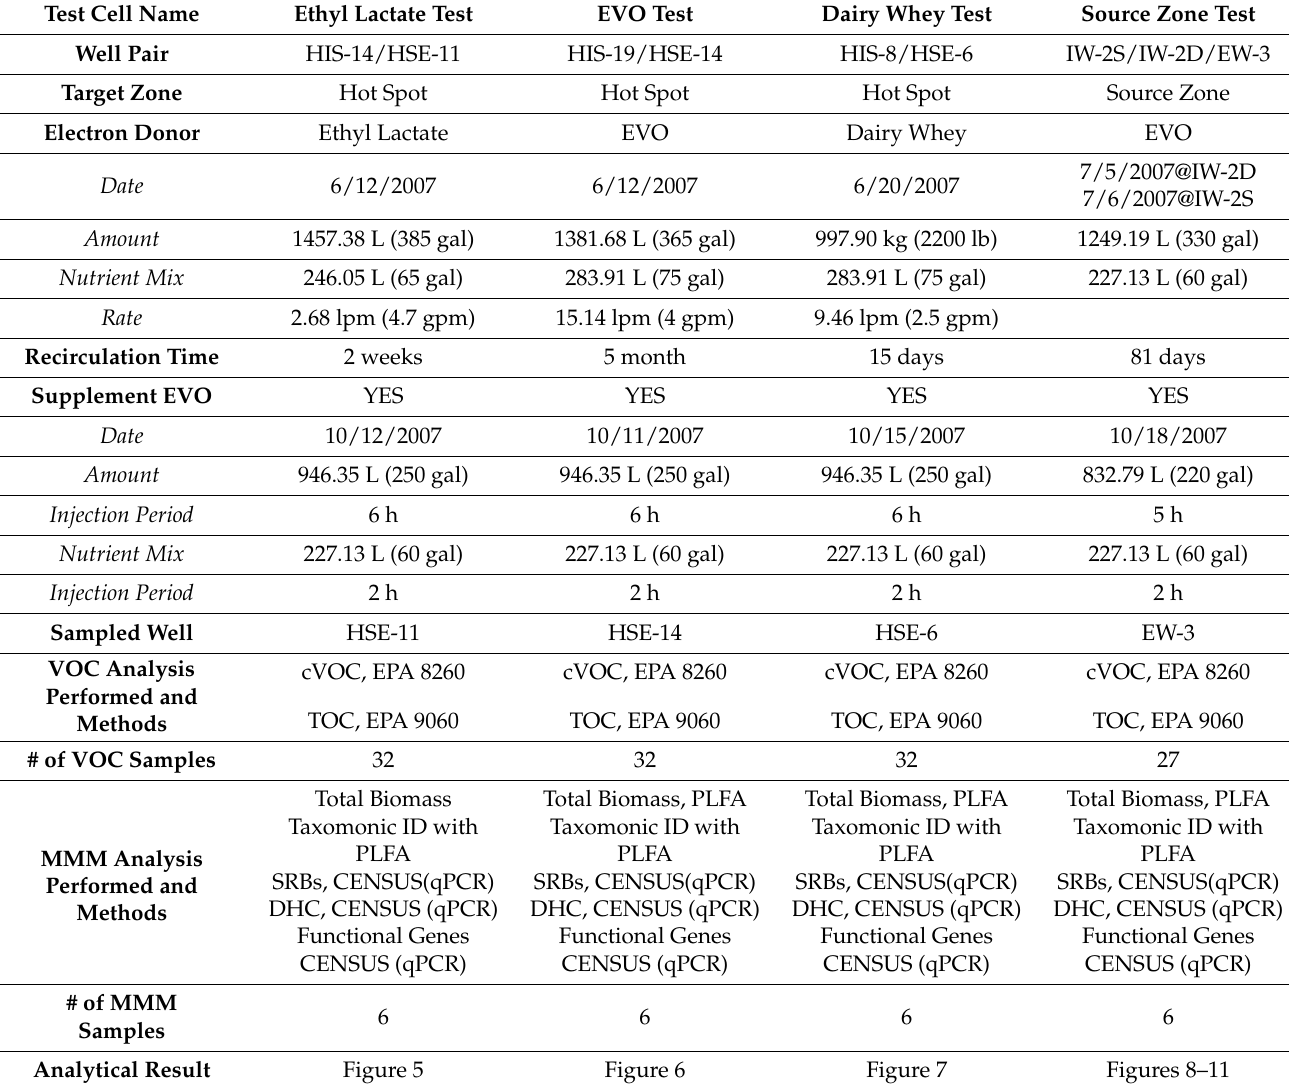
Table 1. Summary of electron donor addition, sampling analysis, and method details by test